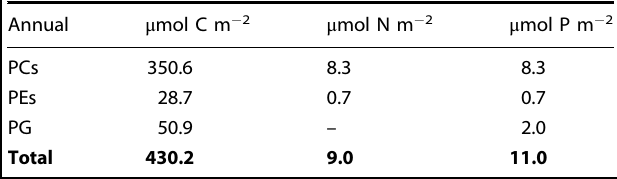
Table 1. Estimated annual deposition fl uxes of organic carbon, organic nitrogen and phosphorus originating from PLs compounds quanti fi ed in this study in East Mediterranean atmosphere. Annual